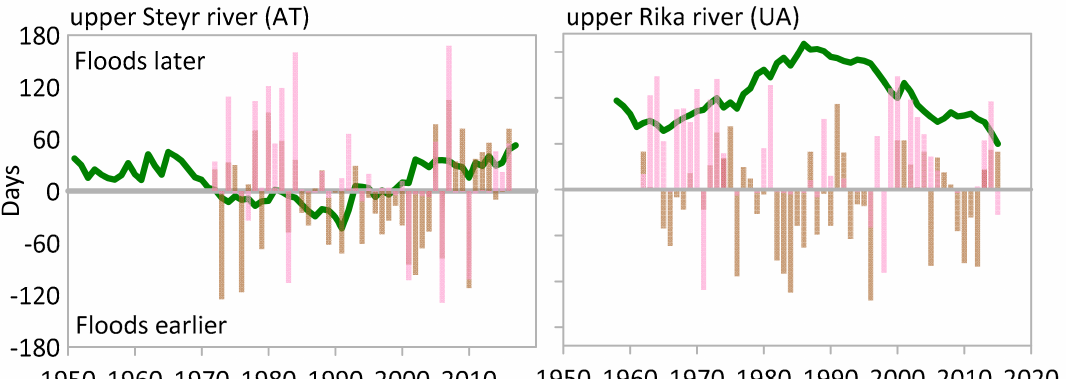
Figure 8. Difference in the occurrence of winter floods and the occurrence of maximum precipitation (pink bars) and melt index (brown bars). Positive difference (days) indicates that floods occur later than maximum (seven − day) precipitation or occurrence of (seven-day) positive air temperatures. The green line indicates the fluctuation index of the winter